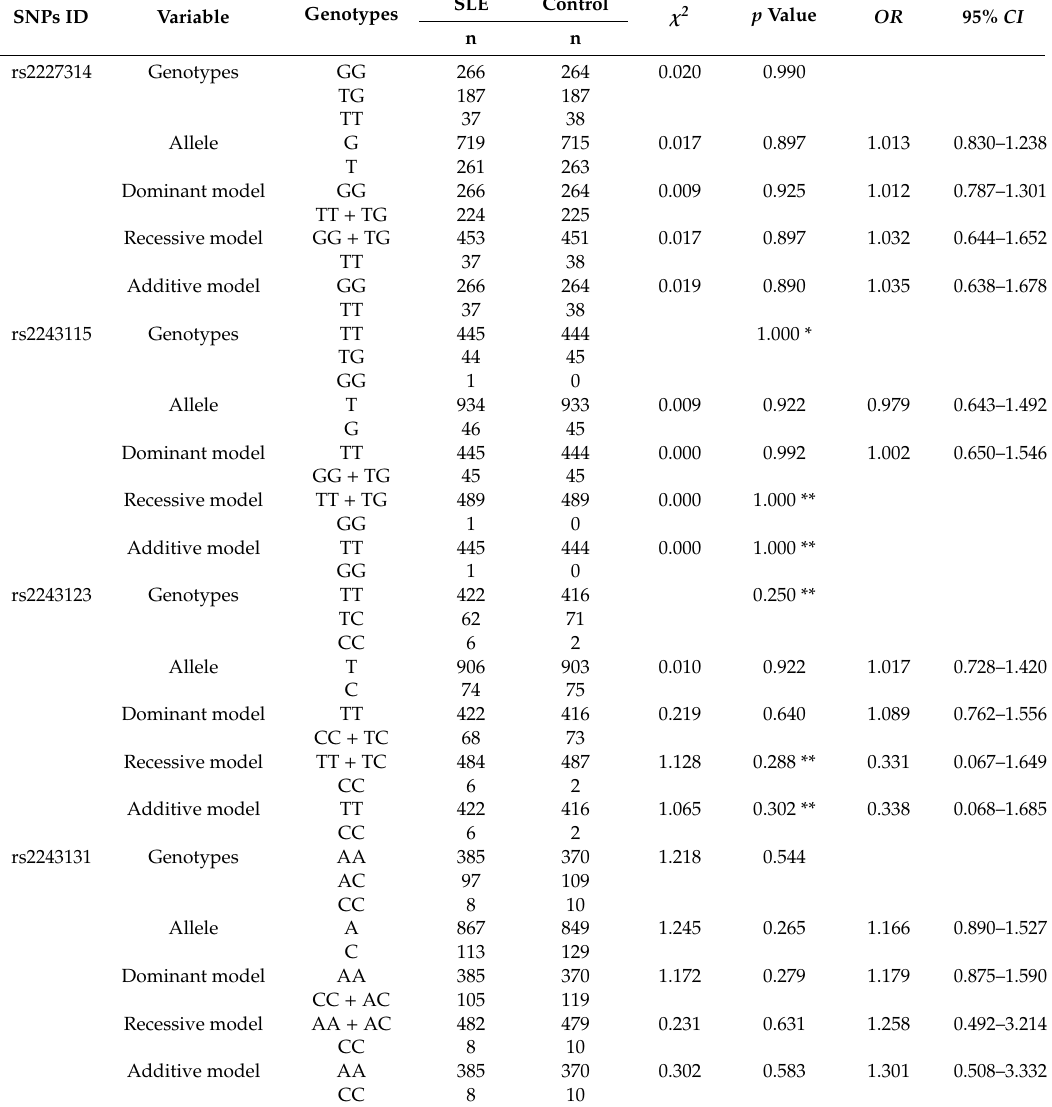
Table 3. Genotype and allele frequencies of genotyped SNPs in SLE patients and healthy